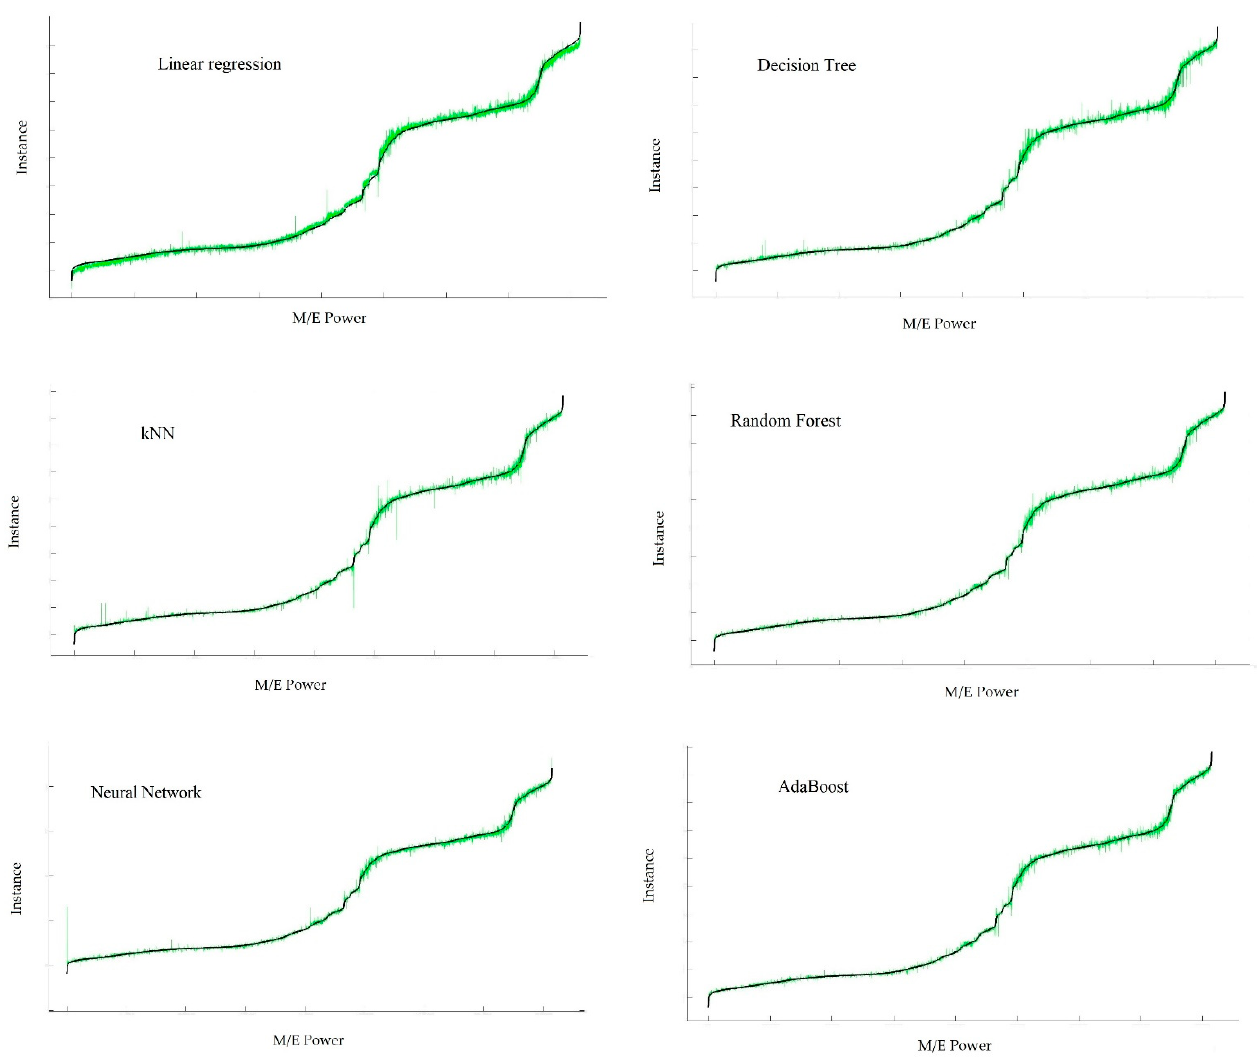
Figure 13. Conjunction between actual and predicted values.